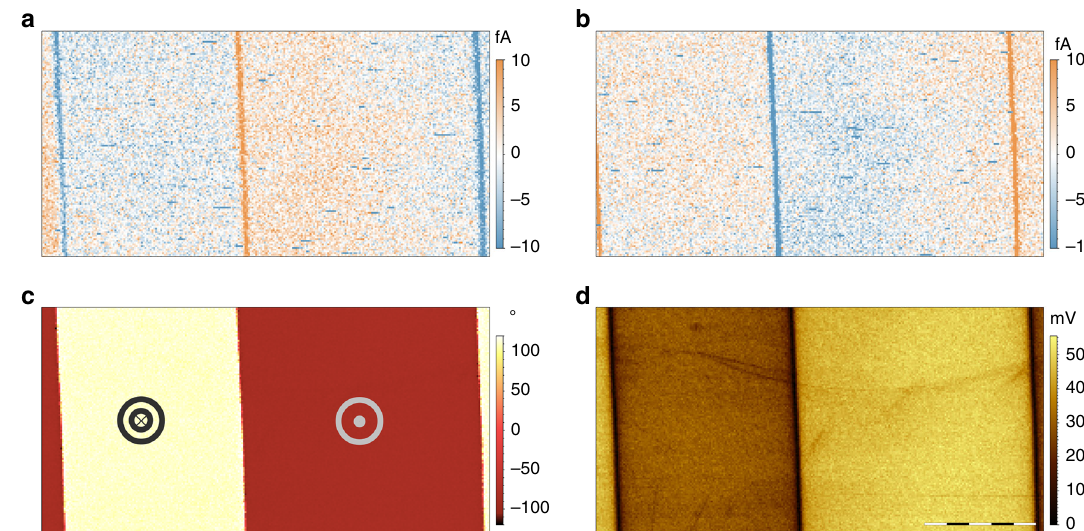
Fig. 2 Piezogenerated charge of periodically poled lithium niobate (PPLN) a Piezo-generated current map of PPLN obtained when the tip scans from left to right-trace (DPFM-Si). b Piezo-generated current map of PPLN obtained when the tip scans from right to left-retrace (DPFM-So). Current is generated at domain walls, orange and blue vertical lines, where the tip strains and unstrains domains of opposite polarization. Inside the domains, a near zero current signal is observed, however a small contrast is present that can be due to surface screening recharging process. c PFM phase image and d PFM amplitude image of the same sample, obtained simultaneously with DPFM signals, scale bar 7.5 μ m. In order to obtain DPFM signals an AC bias was connected to